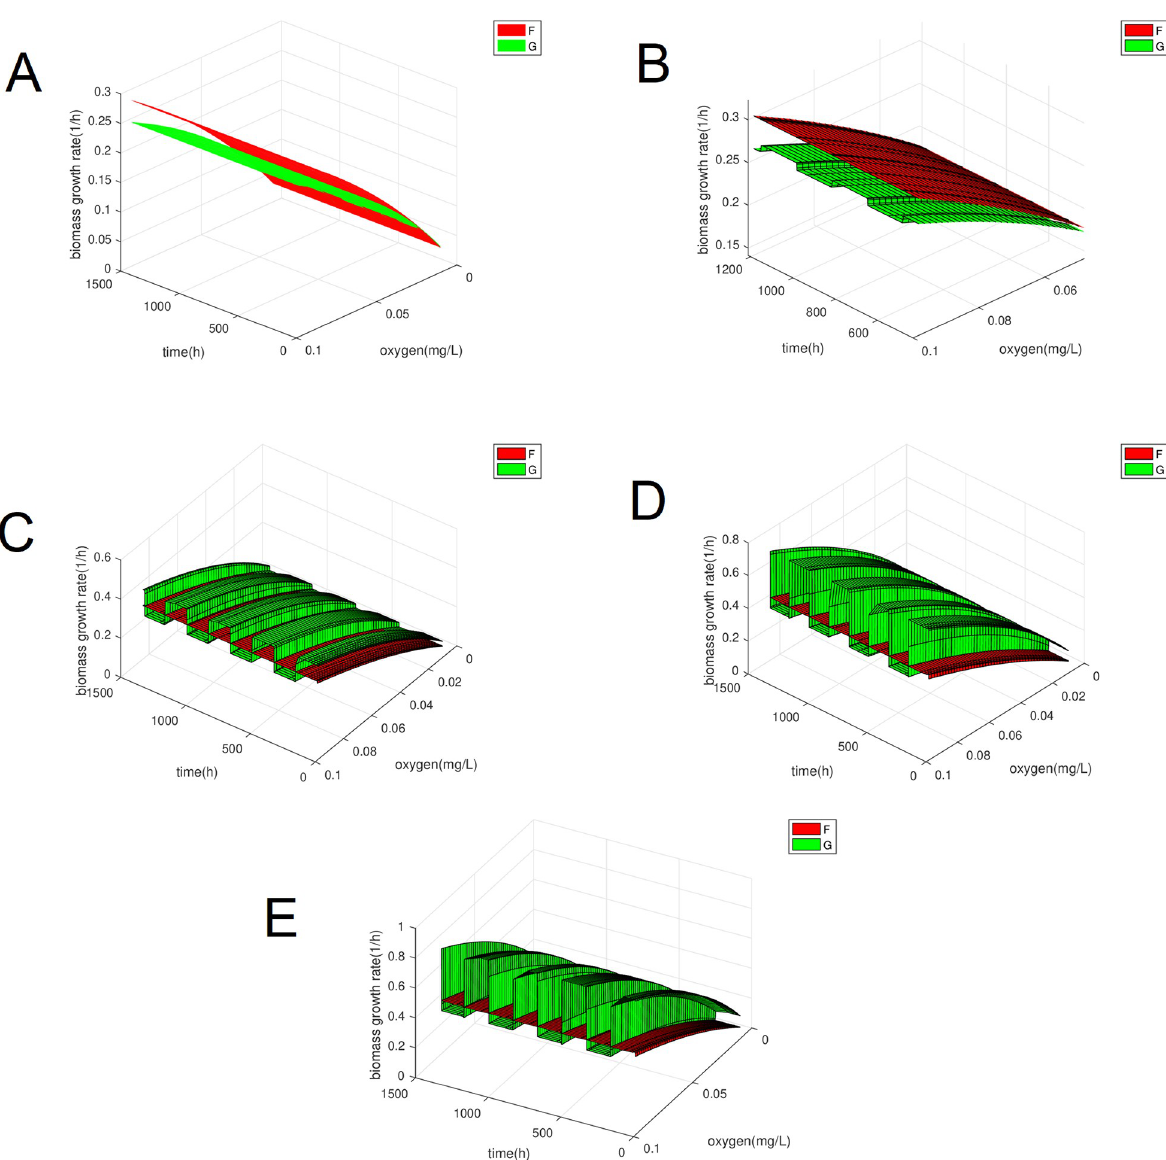
Fig 9. Biomass growth rates F,G for 5 different values of the power of the mass variable, n, in the individual growth rate functions. (A) Biomass growth rates for n = 1. (B) Biomass growth rates for n = 0.95. (C) Biomass growth rates for n = 0.5. (D) Biomass growth rates for n = 0.1. (E) Biomass growth rates for n =